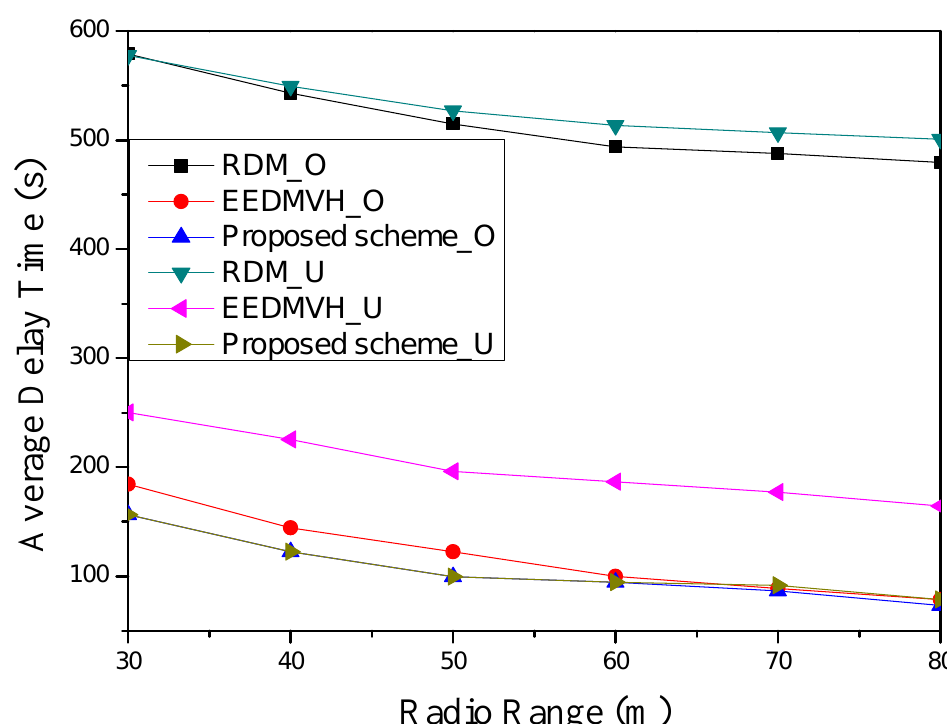
Figure 13. The average delay time according to the radio range of a